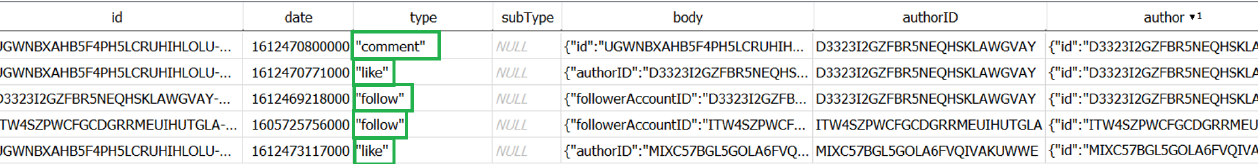
Figure 5. The contents of byte.db\ActivityEntry from Byte Android investigation demonstrating as shown in DB Browser for SQLite.